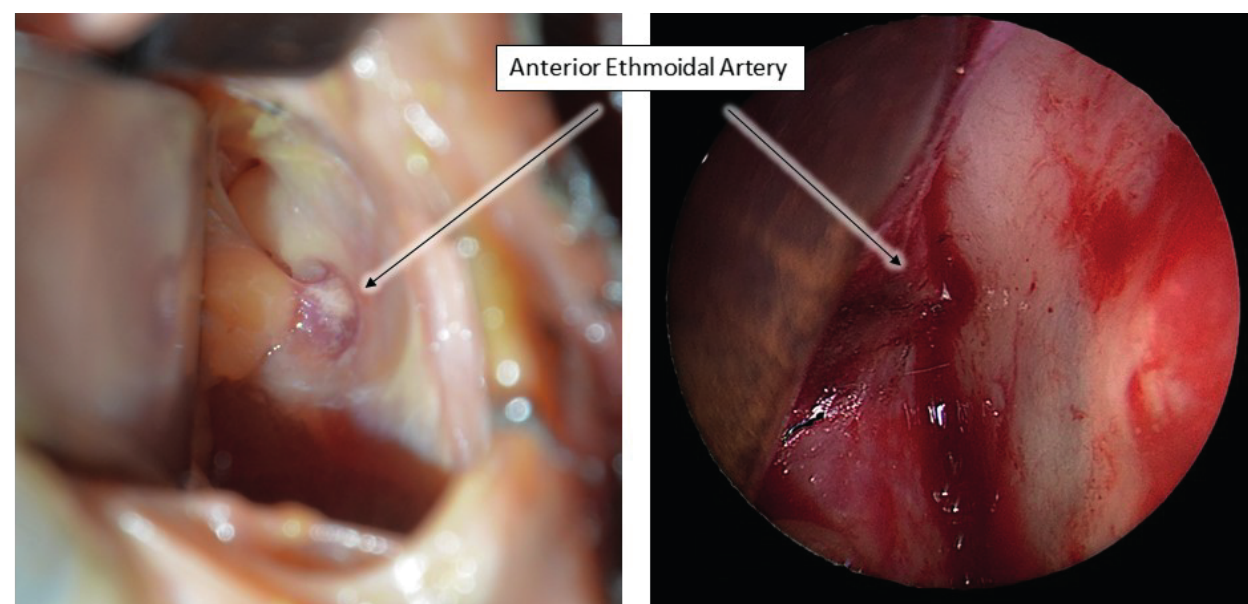
Figure 4. Identification of the anterior ethmoidal arteries with cadaveric (cadaver, left) and operative (patient, right) demonstration.